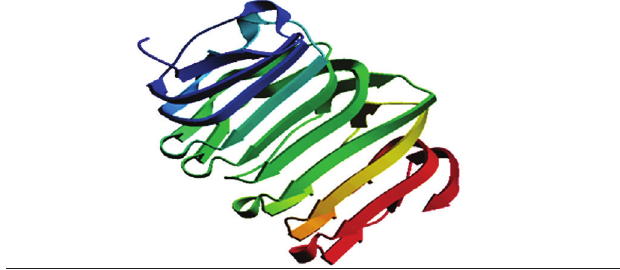
figurE 20 − TSHR protein [ Homo sapiens ] TSHR: thyroid-stimulating hormone